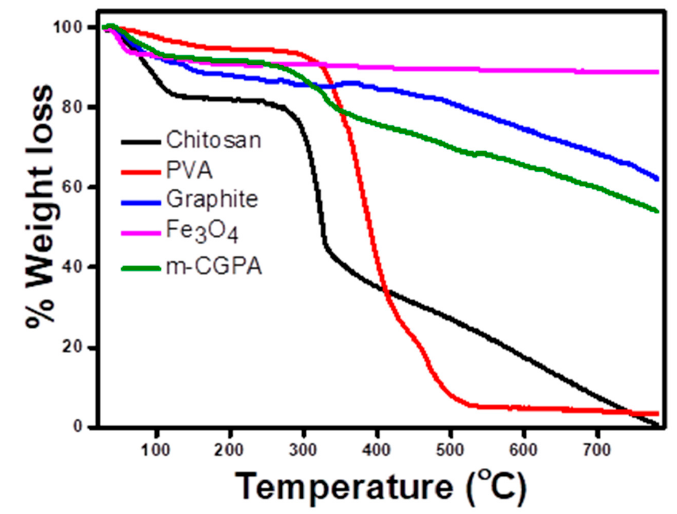
Figure 7. TGA curves of Chitosan, PVA, Graphite, Fe 3 O 4, and m-CGPA.